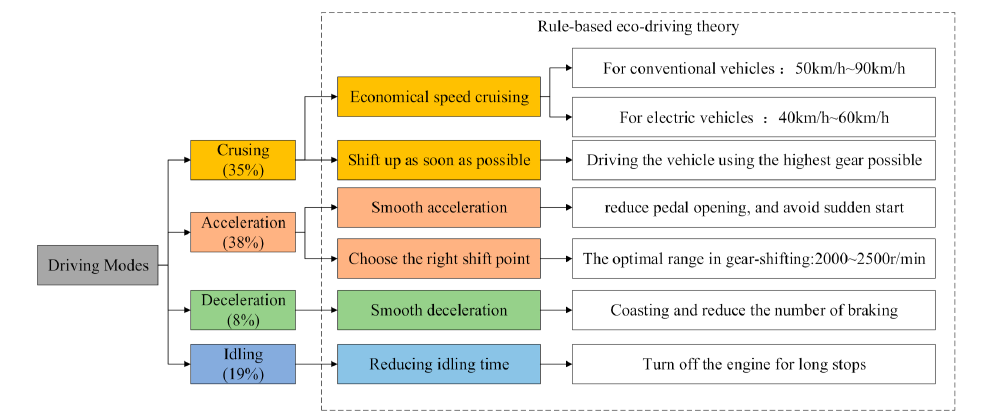
Figure 4. Rule-based eco-driving theory in the main driving